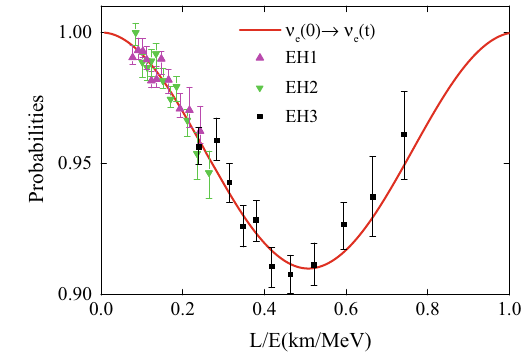
Fig. 1 The survival probability ν e → ν e (solid line, red) as a function of the distance traveled per energy L / E with the initial electron flavor state. The solid line denotes the theoretical value. The data of the Daya Bay collaboration in three underground experimental halls (EH1: pink, uppertriangle;EH2:green,lowertriangle;EH3:black,square)aretaken from Ref.